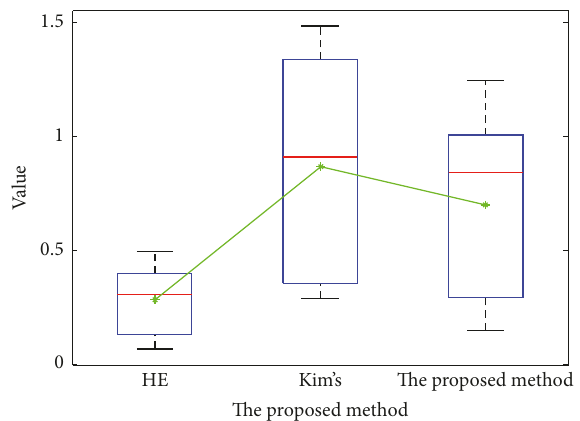
Figure 15: Operating time by HE, Kim’s, and the proposed